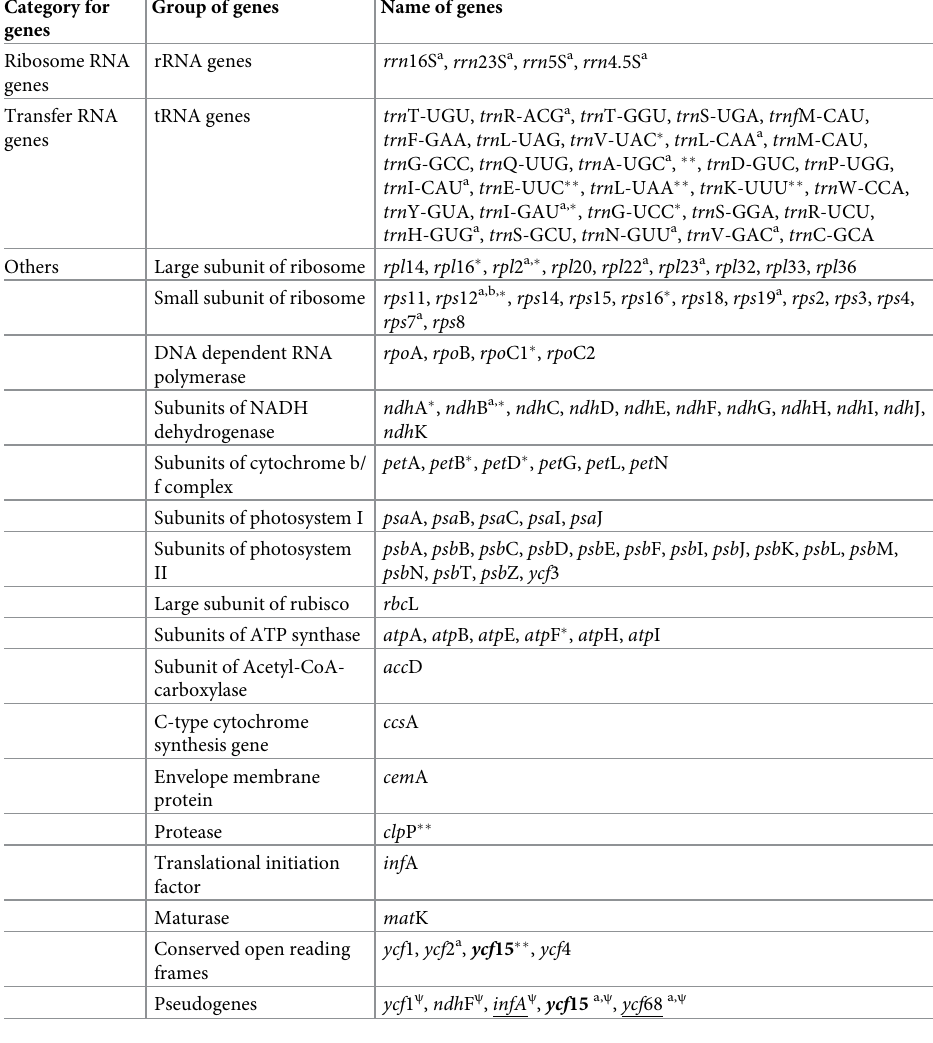
Table 2. Genes presented in chloroplast genomes of Stemona sessilifolia , Asparagus officinalis and Carludovica palmata